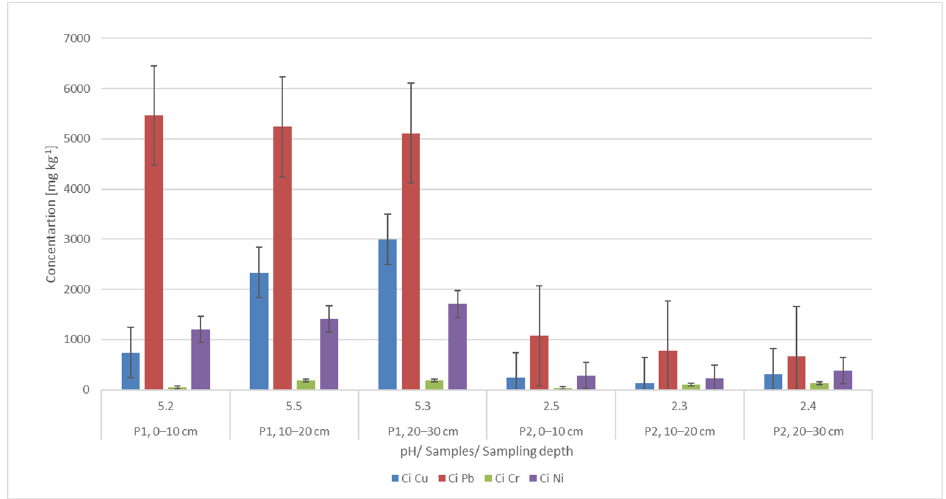
Figure 2. Initial metal concentration and pH of soil samples as a function of sampling location and depth.